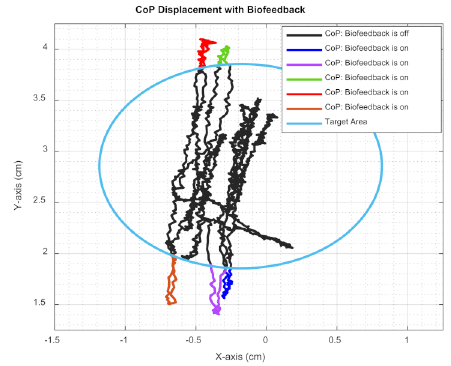
Figure 7. CoP displacement with biofeedback.